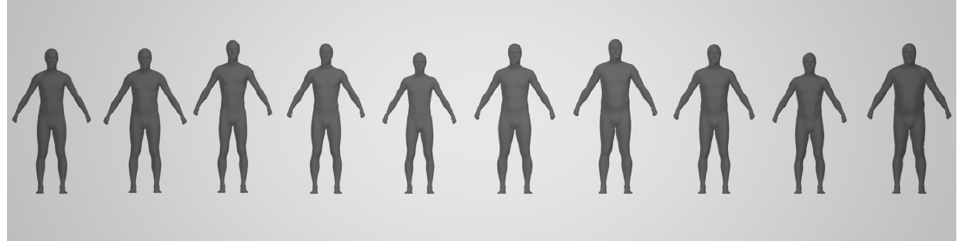
Figure 5. A front-view of the standing 3D models generated of the 10 participants. Appl. Sci. 2020 , 10 , x FOR PEER REVIEW